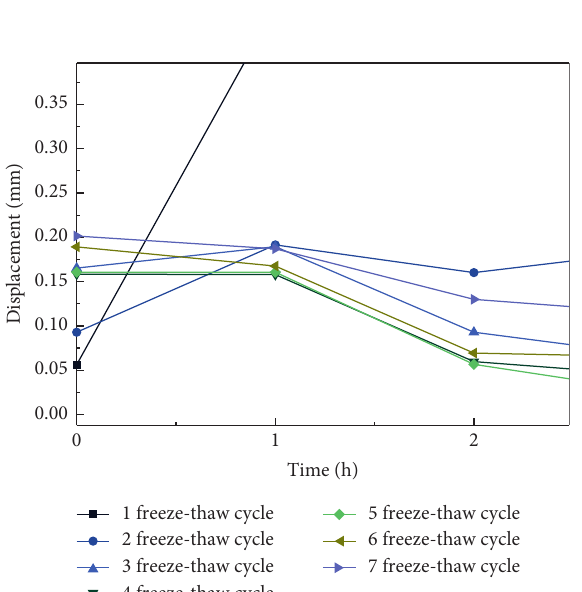
Figure 8: Curve of displacement and deformation (0–2h local amplification).